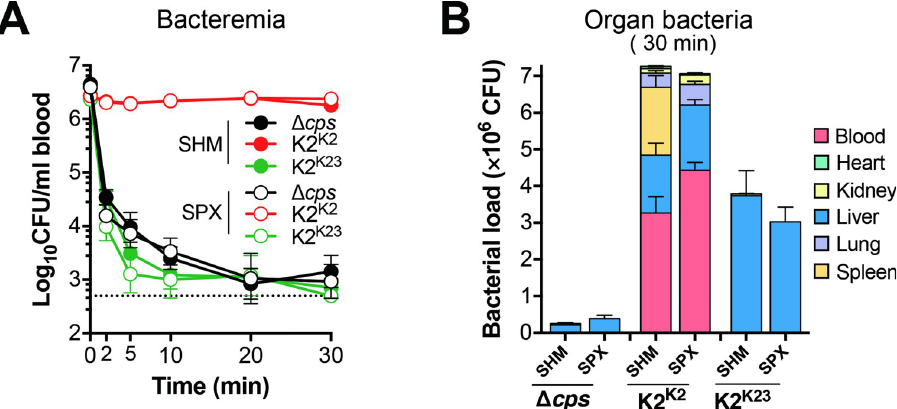
Fig 4. Dispensable role of the spleen in the clearance of blood-borne K . pneumoniae in the early phase of septic infection. A. Bacterial kinetics in the blood circulation of asplenic mice. The spleens of CD1 mice were surgically removed (splenectomy, SPX) 7 days before i.v. infection with 5 × 10 6 CFU of ATCC43816 (K2) or isogenic acapsular mutant ( Δ cps ) and capsule switched LV strain (K2 K23 ). CFU counts in the blood were enumerated on agar plates. Mice with sham operation (SHM) were used as a negative control. Dash line denotes the detection limit. n = 4. B. Bacterial distribution in the major organs of asplenic mice. CFU counts in the blood and major organs of asplenic mice were compared with those of sham operation control 30 min post i.v. infection as in (A). n = 4. The data were from one experiment and presented as mean ±